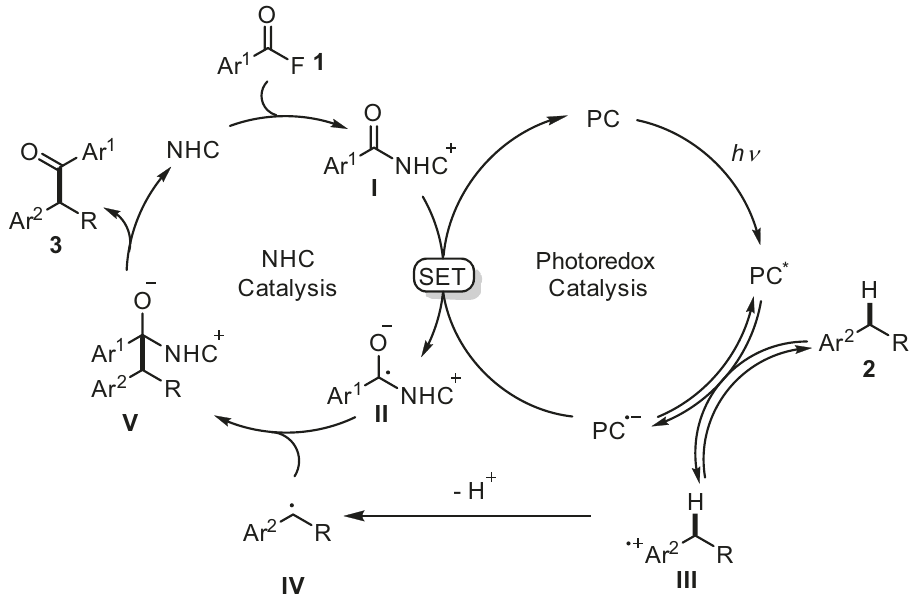
Fig. 5 Plausible reaction mechanism. Cooperative NHC/photoredox catalysis where the acylazolium ion I is involved in both catalytic cycles. PC photocatalyst, NHC N-heterocyclic carbene, SET